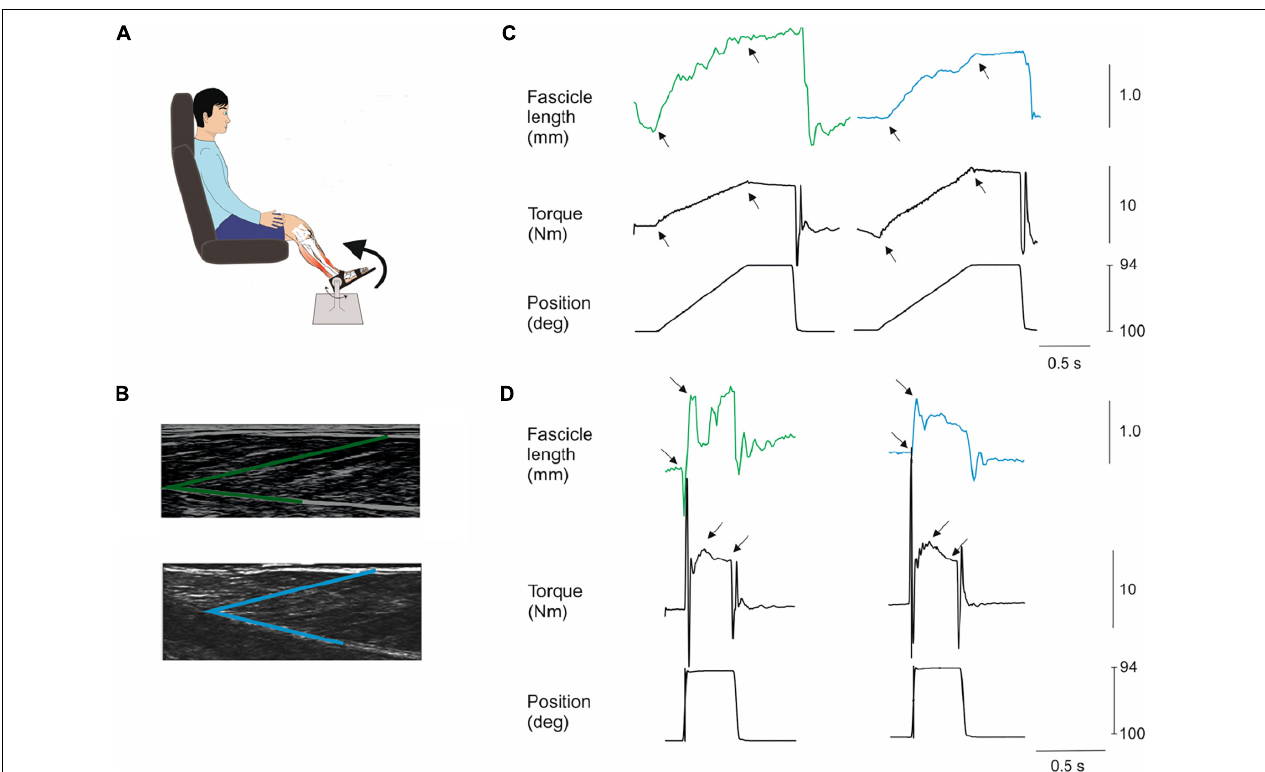
FIGURE 1 | Methods. Subjects were seated in a reclining armchair with the examined leg supported and the foot attached to a plate which could be rotated by a computer-controlled electromotor (A) . The hip joint was positioned in 100 deg flexion and the knee fully extended (illustration not true to reality in this respect). Slow (7 deg/s) and fast (200 deg/s) dorsiflexion rotations of the foot plate were applied at different positions of the ankle joint throughout the range of movement at 10 deg. intervals. An ultrasound probe was placed over the medial aspect of the lower limb to monitor the length of medial gastrocnemius muscle fascicles during the stretches (B) . A single fascicle was selected (marked in green for an NI individual and in blue for an individual with CP) and its length from the superficial to the deep aponeurosis of the muscle was tracked throughout the experiment. (C,D) show examples from an NI individual (left hand graphs) and individual with CP (right hand graphs) of the movement of a fascicle and the torque on the foot plate (black) during a slow (C) and a fast stretch (D) at 100 deg initial ankle position. Black arrows indicate the interval for measurement of fascicle and torque amplitudes. Note the peak in the torque measurement following the fast stretch in (D) indicated by the first arrow. This is the increase of torque elicited by the stretch reflex. The amplitude of this peak was measured in relation to the baseline torque during the holding phase of the stretch as indicated by the second arrow in the torque graphs of (D) . All fascicle measurements are in mm, all torque measurements are in Nm and position are in